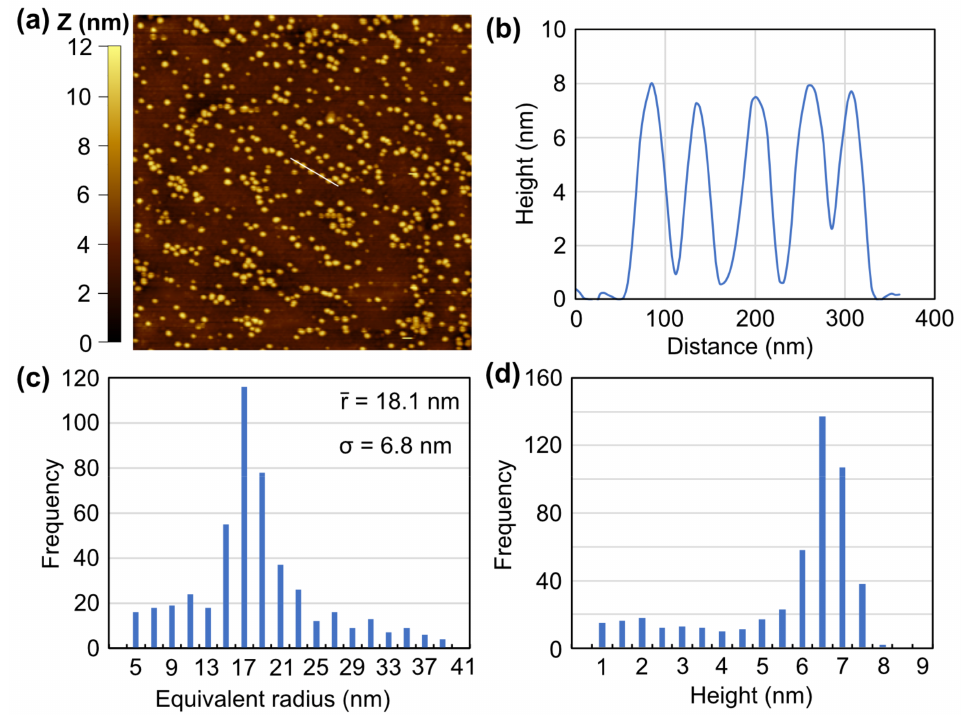
Figure 6. Atomic force microscope image ( a ) of QDs etched at 0.4 V for 30 min, similar to Figure 4f. A plot ( b ) of height versus distance for the cross-sectional line (white) in ( a ). Frequency versus bins of QD equivalent radius ( c ) and height ( d ) for the image shown in ( a ). The QDs have a tight distribution for radius with a mean value of 18.1 nm. The QD heights are concentrated at ~7.5 nm, the initial InGaN thin film